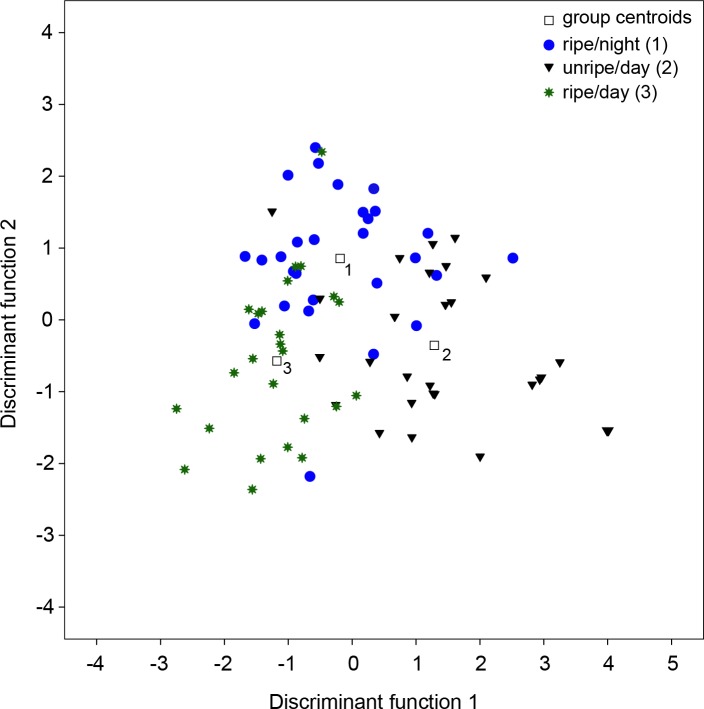
Comparison of scent bouquets.Comparisons of unripe fruits during day, ripe fruits at night and ripe fruits during day base on the composition of their chemical compounds using canonical discriminant function analysis (DFA).